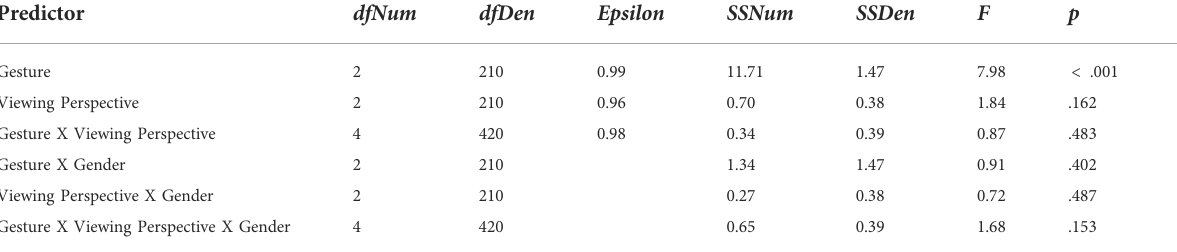
TABLE 3 Results of the mixed-measures ANOVA for the perceived likability of the robot. Predictor dfNum dfDen